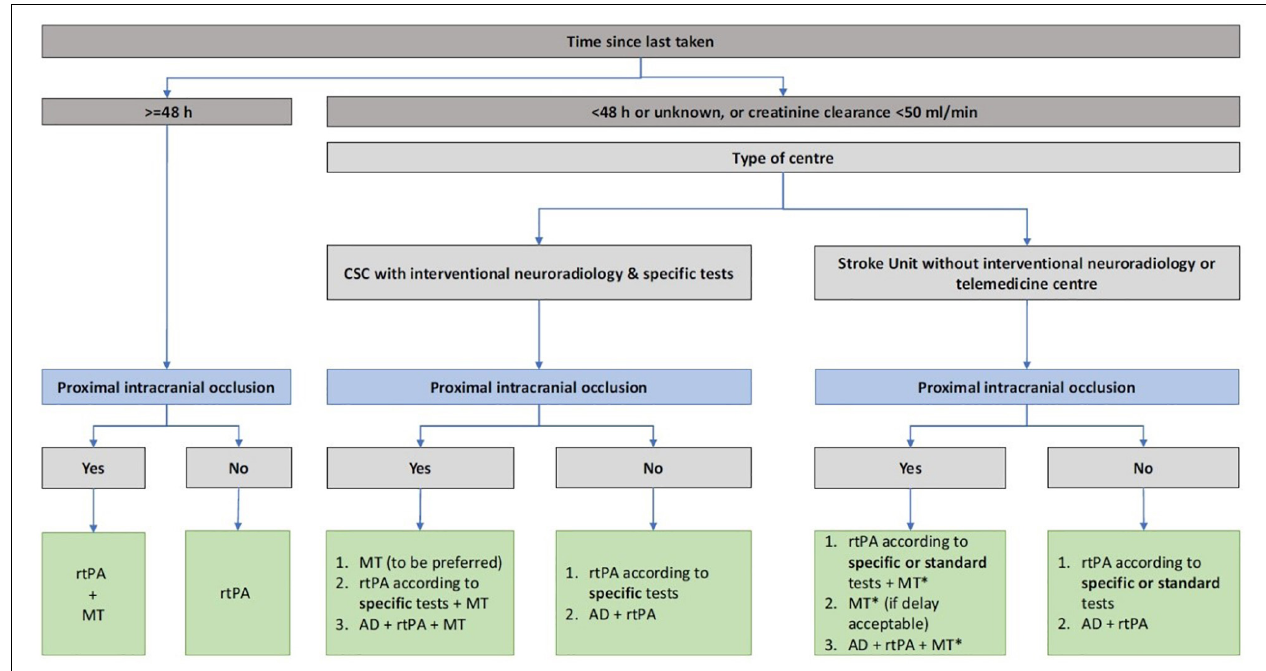
FIGURE 4 | The different treatment of acute ischemic stroke in patients according to the last dosing time of novel oral anticoagulant, renal function, stroke center